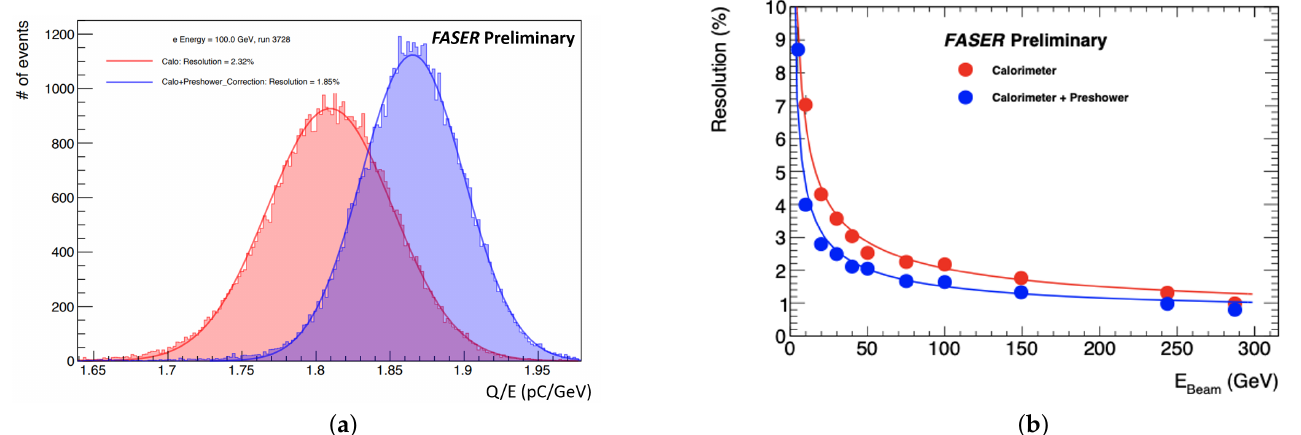
Figure 9. ( a ) Thechangeindepositedchargeasaresultofthepre-showercorrection. ( b ) The improvement in energy resolution as a result of the pre-shower correction.